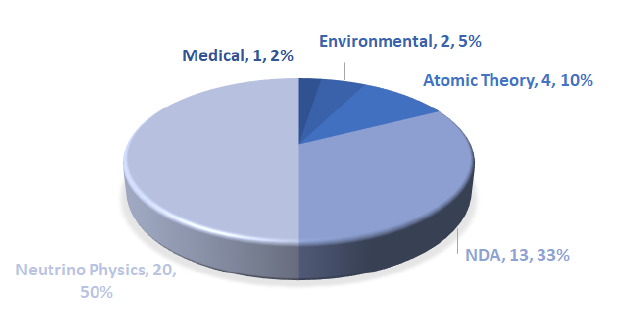
Figure 3. Applications of DES detectors. The nuclides measured with DES have varied widely from low energy (<2 MeV) to high energy (>2 MeV) measurements. The former represent electron capture and beta- decaying radionuclides, while the latter are α -decaying nuclides. These are shown in Figure 4. As a function of nuclide, the resolving power does not appear to show any discernible trend other than for each radionuclide there appears to be at least one mea- surement with a low resolving power, indicating that it takes multiple attempts to get a good measurement.